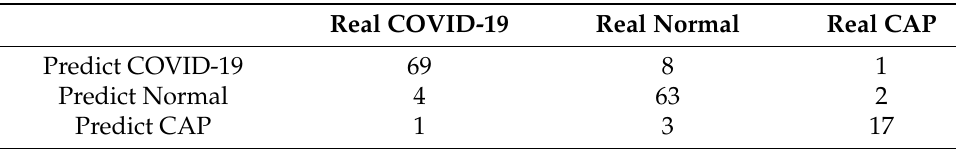
Table 11. Confusion matrix of native ViT on the X-ray Image dataset.